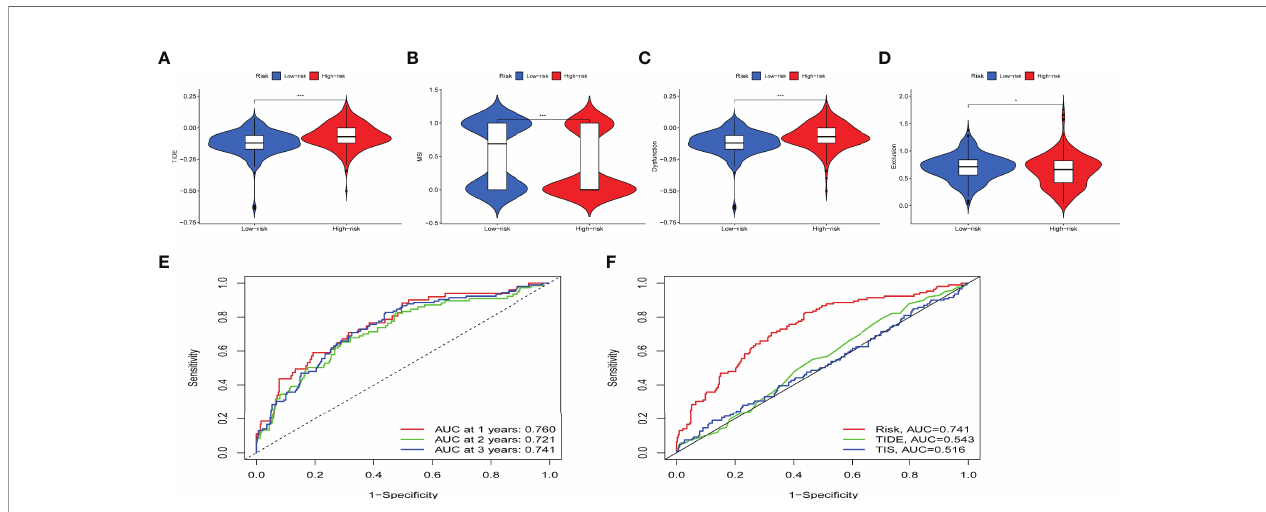
FIGURE 7 | The value of IRPDGs in predicting ICI treatment response and prognosis. (A – D) TIDE, MSI, and T cell exclusion and dysfunction score in different IRPDGs subgroups. The scores were compared using the Wilcoxon test (ns: not signi fi cant, *P < 0.05, ***P < 0.001). (E) IRPDGs predict overall survival at 1, 2, and 3 years for ccRCC treated with ICI. (F) Advantages of IRPDGs over TIDE and TIS for prognostic